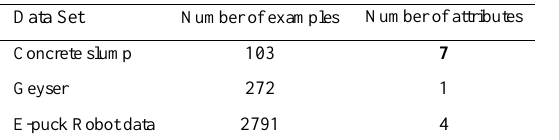
Table 1. Summary description for the data sets of the study.